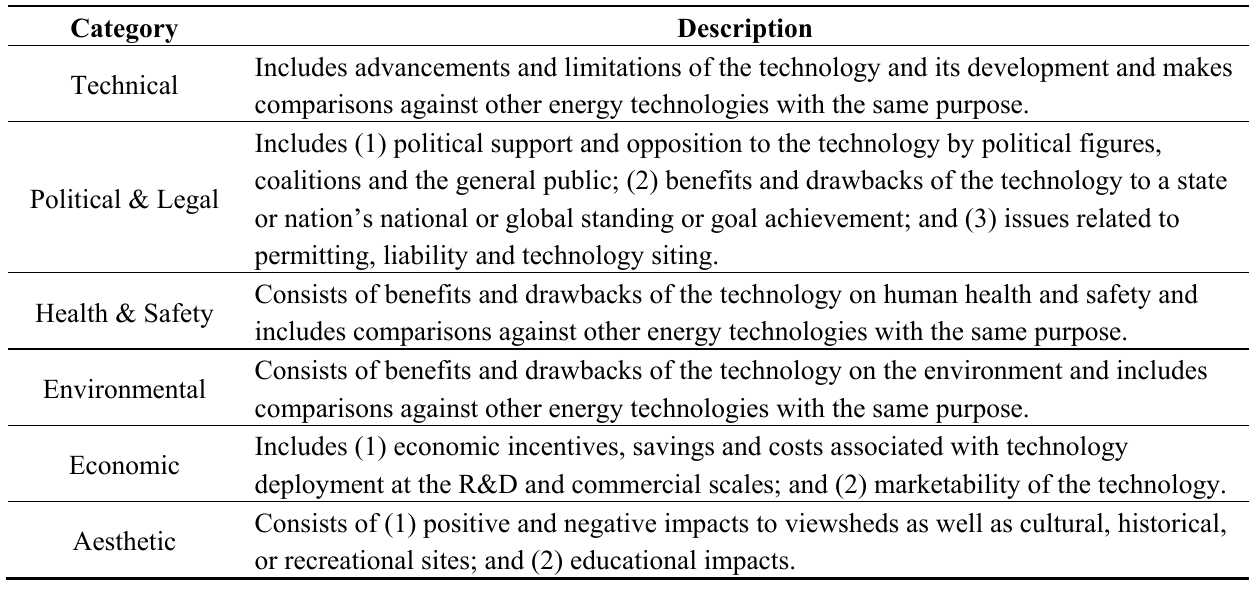
Table 1. SPEED framework system